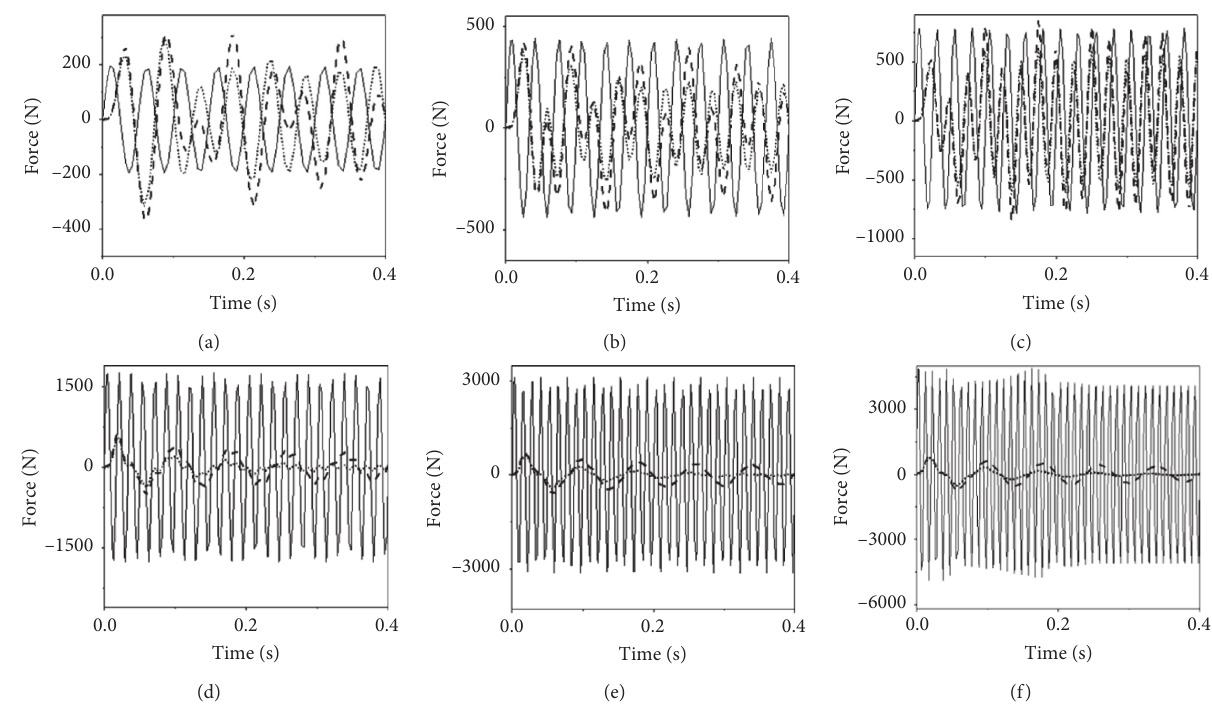
Figure 9: The force transmitted to the base under different control measures. Solid line: excitation force; dashed line: passive isolation; dotted line: optimal control. (a) r � 600 r/min, (b) r � 900r/min, (c) r � 1200r/min, (d) r � 1800r/min, (e) r � 2400r/min, and (f) r � 3000r/min.